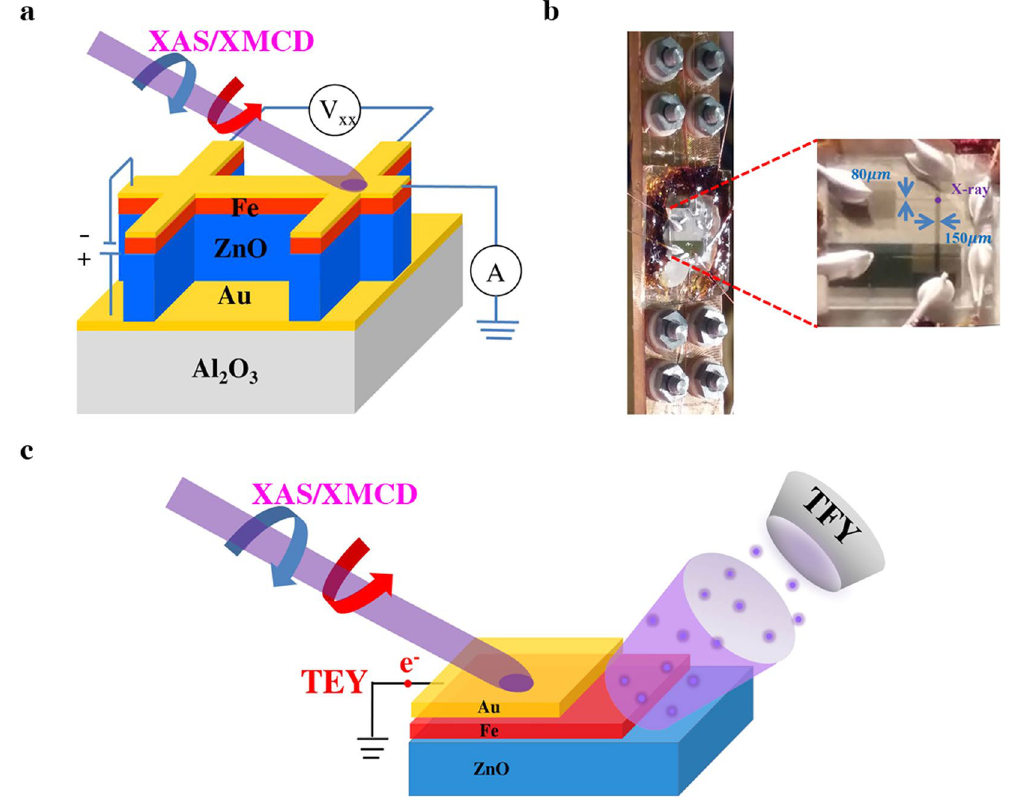
Figure 2. In-situ x-ray setup and deice layout. ( a ) Illustration for the geometric layout of the Hall bar device with respect to x-ray measurements (XAS/XMCD) under the applied voltage (polarity is shown). For x-ray measurements, voltage was applied along vertical direction of the device (CPP). While for AMR measurements, voltage was applied along horizontal direction of the device (CIP). ( b ) The real configuration of employed circuits on the device and the x-ray sample holder. ( c ) Illustration for the tuning of x-ray collection mode in relation to sample profiling (i.e., TEY and TFY are surface and bulk sensitive, respectively). The zoom-in figure of ( b ) shows the details (pattern linewidth, connection, and x-ray hitting spot) of the device layout on the x-ray